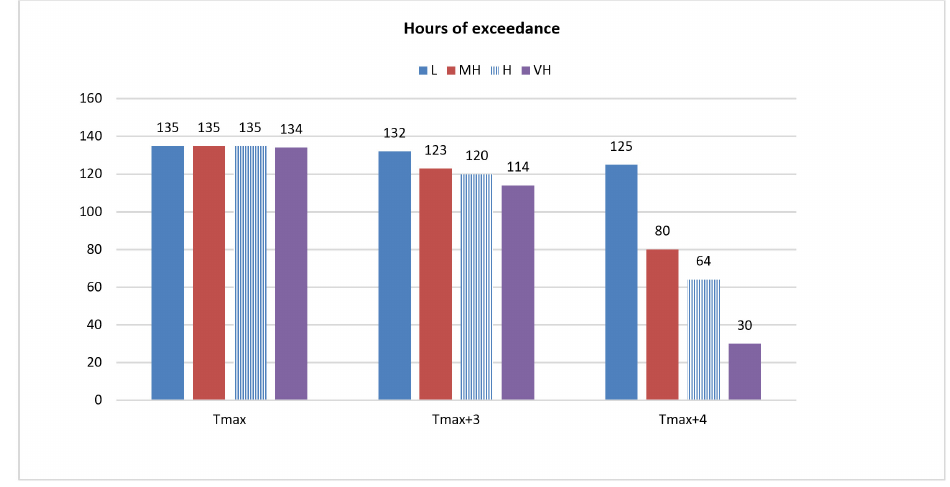
Figure 9. Hours of exceedance in all tested rooms during 24 August–1 September 2019, Hours